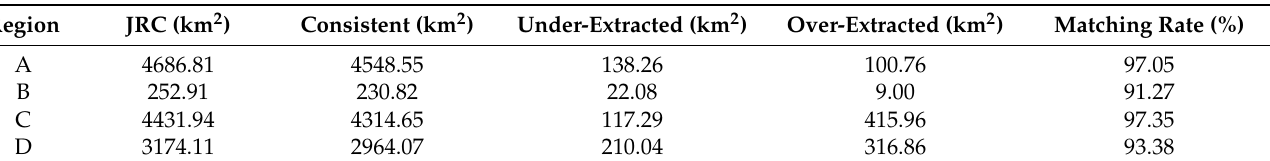
Table 1. Spatial comparison of China-ASWD compared to JRC water body data in 2019 for regions A, B, C and D.